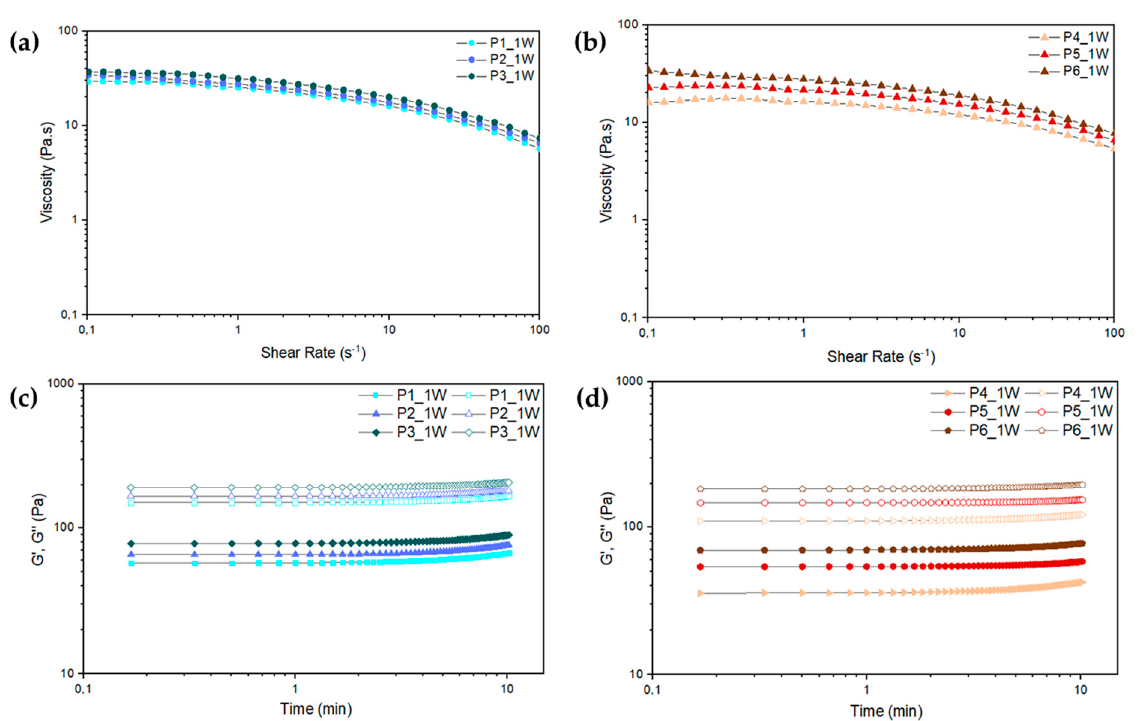
Figure 1. ( a ) Flow curves of pastes 1 to 3 after 1 week (W) of being produced; ( b ) Flow curves of pastes 4 to 6 after 1 week of being produced; ( c ) Oscillatory sweep curves of pastes 1 to 3 after 1 week; ( d ) Oscillatory sweep curves of pastes 4 to 6 after 1 week; Storage modulus (G ′ ) represented by solid-colored forms and loss modulus (G ″ ) represented by hollow-colored forms. Table 1. Blend at two different ratios of the chitosan solution with three different PVA/HA pastes to attain six paste formulations with varying PVA content and the CS/PVA/HA pastes solid content. Paste Formulation (wt.%) Paste Solids Content (wt.%) Paste Designation